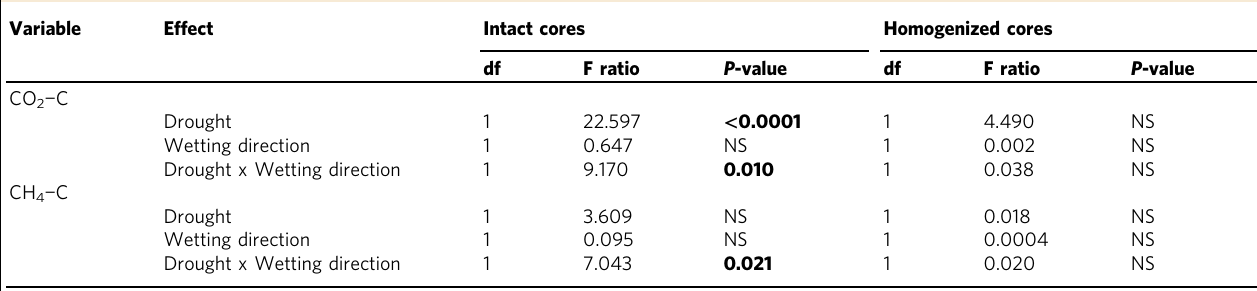
Table 2 Statistical summary for cumulative carbonaceous greenhouse gas emissions from incubated cores measured during rewetting and 20 h post rewetting